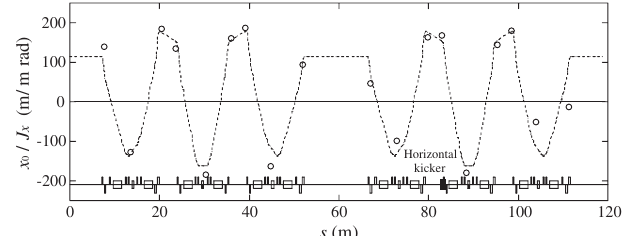
FIG. 1. Horizontal amplitude dependent orbit shift through the ring. The 18 circles are the measured shift at the 18 BPMs and the broken line is the calculated shift using the analytical formula, Eq. (9). The shaded square shows the location of the kicker magnet.